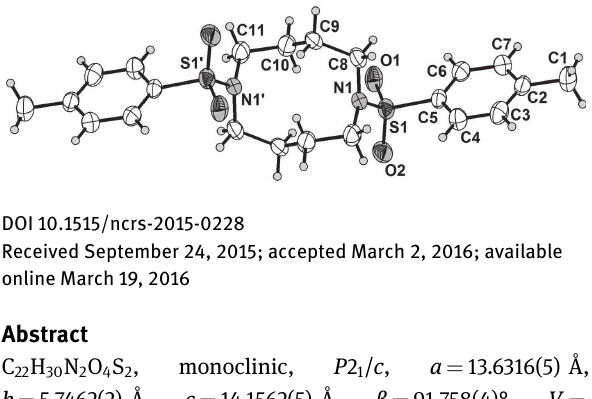
Table 2: Fractional atomic coordinates and isotropic or equivalent isotropic displacement parameters (Å 2